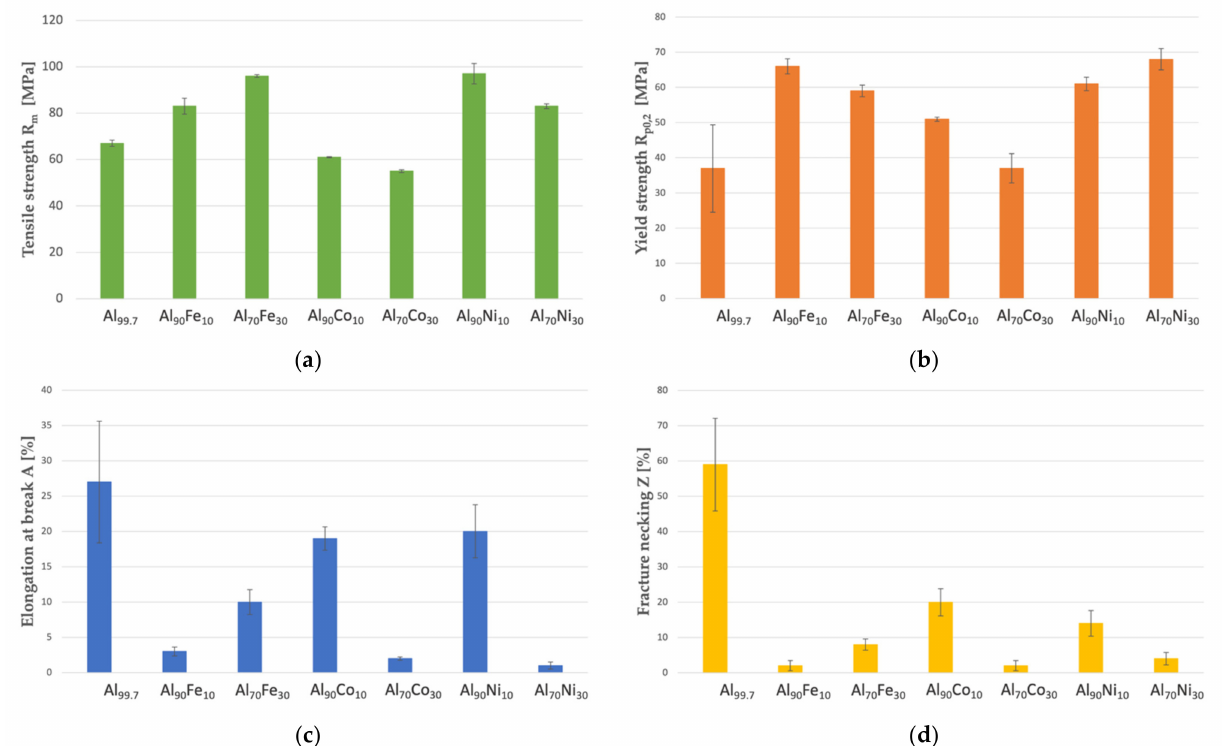
Figure 8. Characteristic values of the tensile test of pure Al and Al composite with different pro- portions of magnetic particles: ( a ) tensile strength, ( b ) yield strength, ( c ) elongation at break, and ( d ) fracture